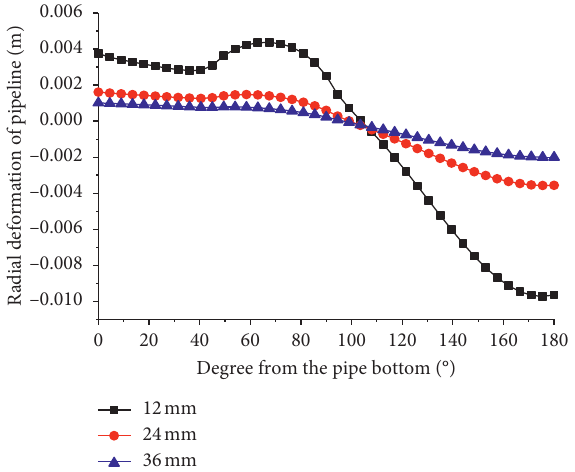
Figure 18: Radial deformation with different pipe thickness.